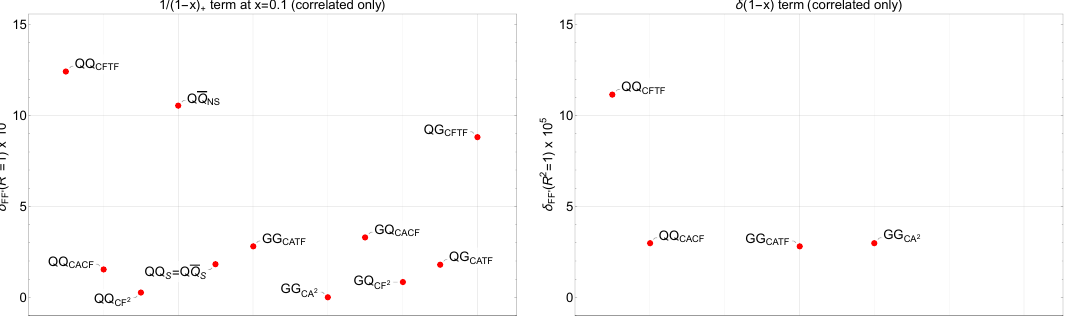
Figure 1 . The quantity δ FF 0 ( R 2 ) as defined in eq. (3.38) evaluated at R = 1 for the different flavour channels for the 1 / (1 − x ) + contribution at x = 0 . 1 (left) and the δ (1 − x ) contribution (right). Note that, as indicated on the y axis, each value of δ FF 0 ( R 2 ) has been multiplied by a factor of 10 5